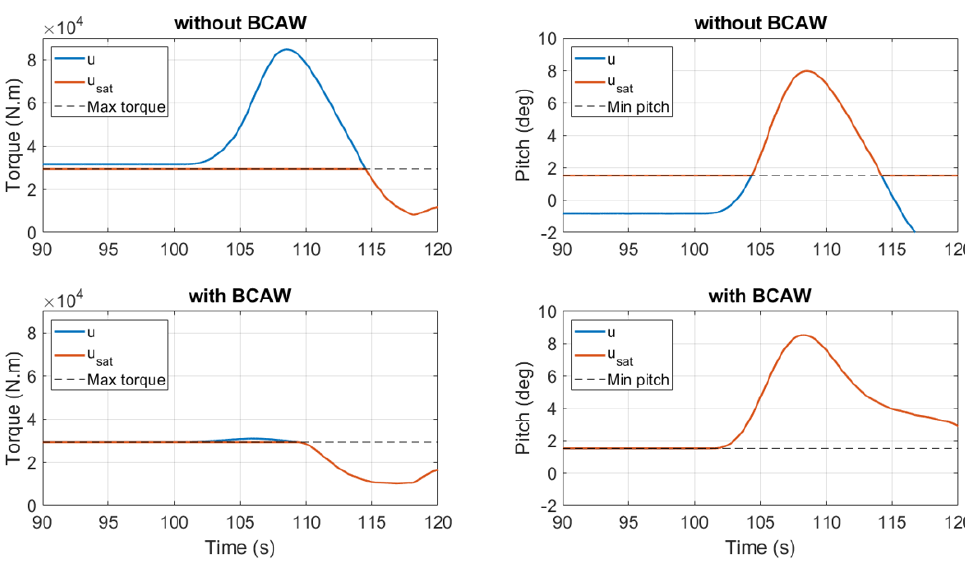
Figure 8. Torque and pitch variations with and without BCAW under gust